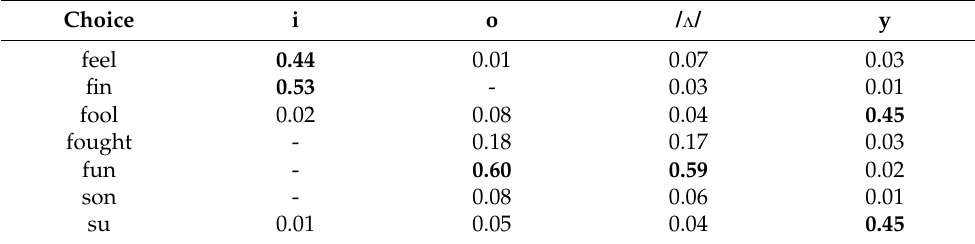
Table 12. The percentage of categorizations of French phonemes in the L1 English group.